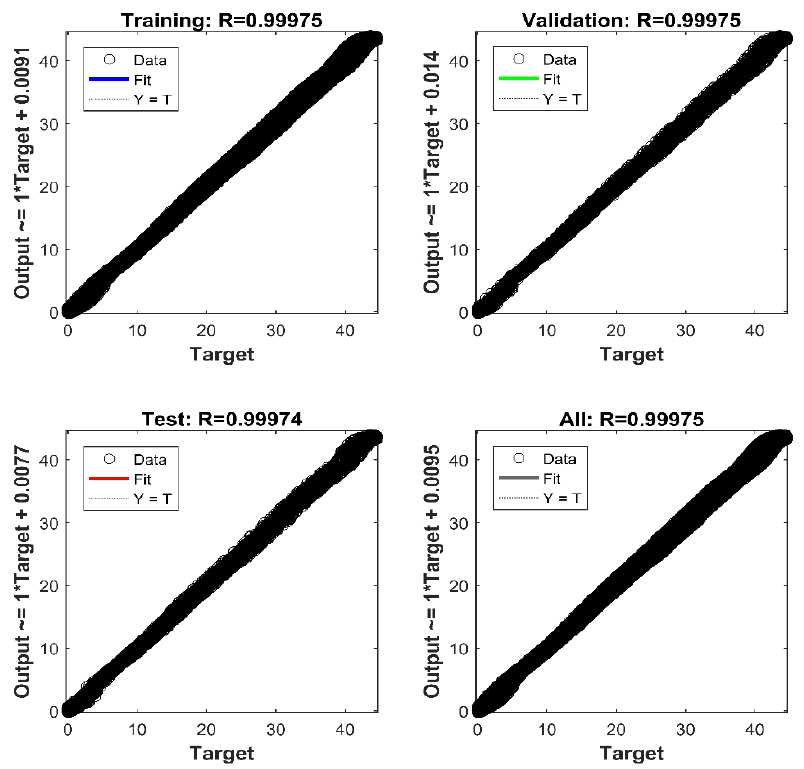
Figure 7. The agreement between the network’s outputs pressure and target pressure for training, validation, test and complete data set.